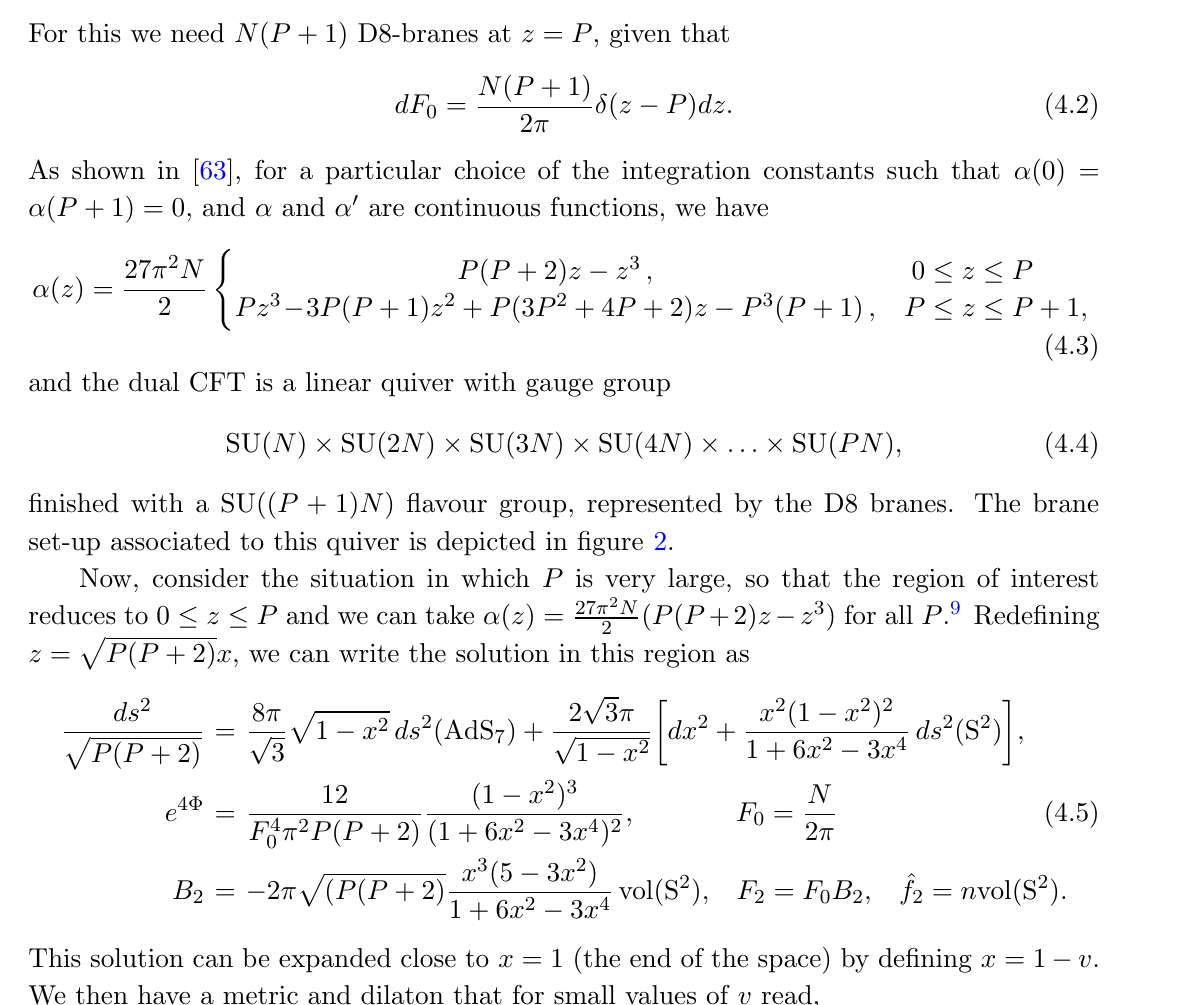
Figure 2 . D6-NS5-D8 brane set-up associated to a linear quiver with increasing ranks terminated by a (cid:13)avour group. NS5 branes are denoted by circles, D6 branes by horizontal lines and D8 branes by vertical